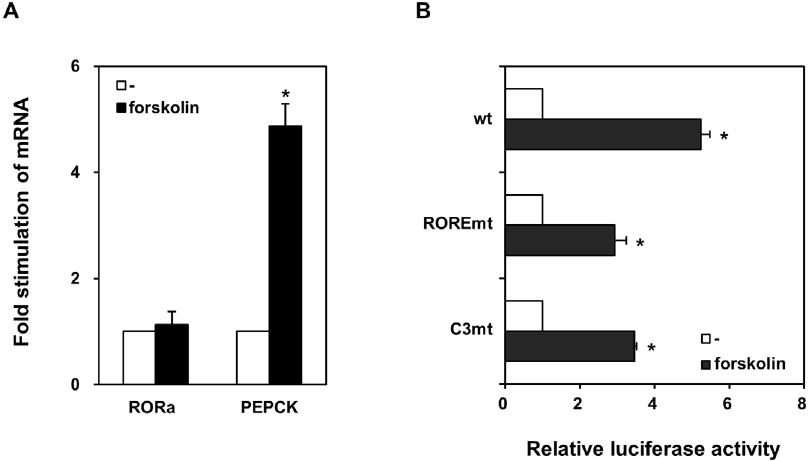
Fig 4. cAMP-dependent stimulation of the PEPCK promoter as mimicked by forskolin. (A) HepG2 cells were treated with (closed bars) or without 10 μ M forskolin (open bars). Expression of ROR α and PEPCK was analyzed by qRT-PCR, and normalized to 18S rRNA. Data are mean ± S.E. (n = 3). (B) HepG2 cells were transfected with luciferase under the control of wild type or mutated PEPCK promoters, and treated with (closed bars) or without 10 μ M forskolin (open bars). Data are shown as mean ± S.E. of three experiments. * , p < 0.05.